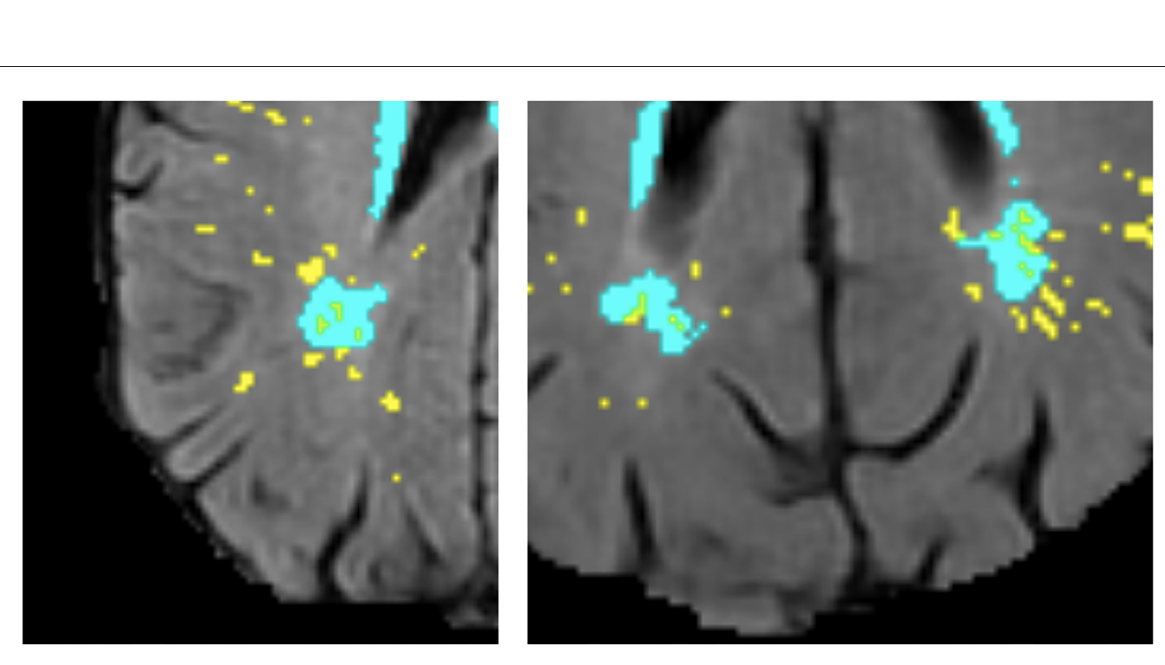
FIGURE11 Examples of large deep WMH in the parietal region that were found spatially close to multiple PVS (segmentation masks for WMH in cyan and PVS in yellow, overlaid on FLAIR